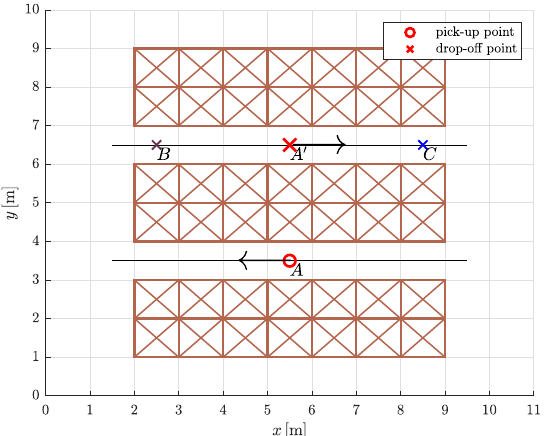
Figure 12. The warehouse floor plan with three pairs of pick-up and drop-off points: A and A (cid:48) , A and B , A and C .